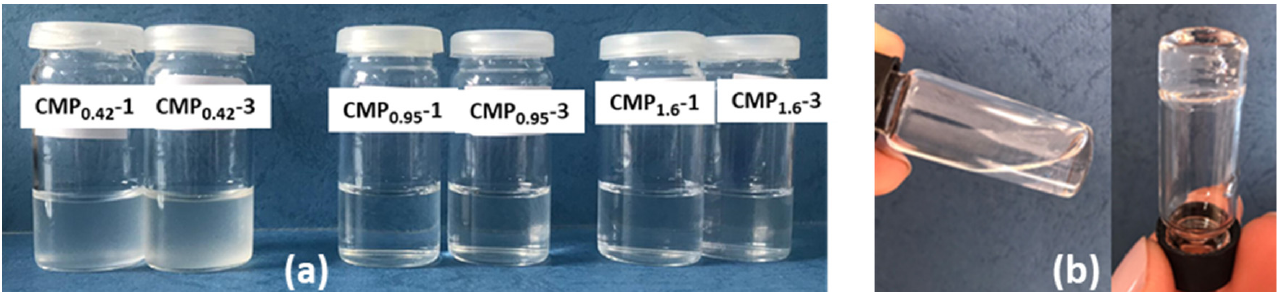
Figure 4. ( a ) Concentrated poloxamer solution (17%) with 1% and 3% added CMP 0.42 , CMP 0.95 , and CMP 1.6 (from left to right) at room temperature. ( b ) Tube inversion method for 17% poloxamer with 1% CMP 0.95 below ( left ) and above ( right ) the gelation temperature.